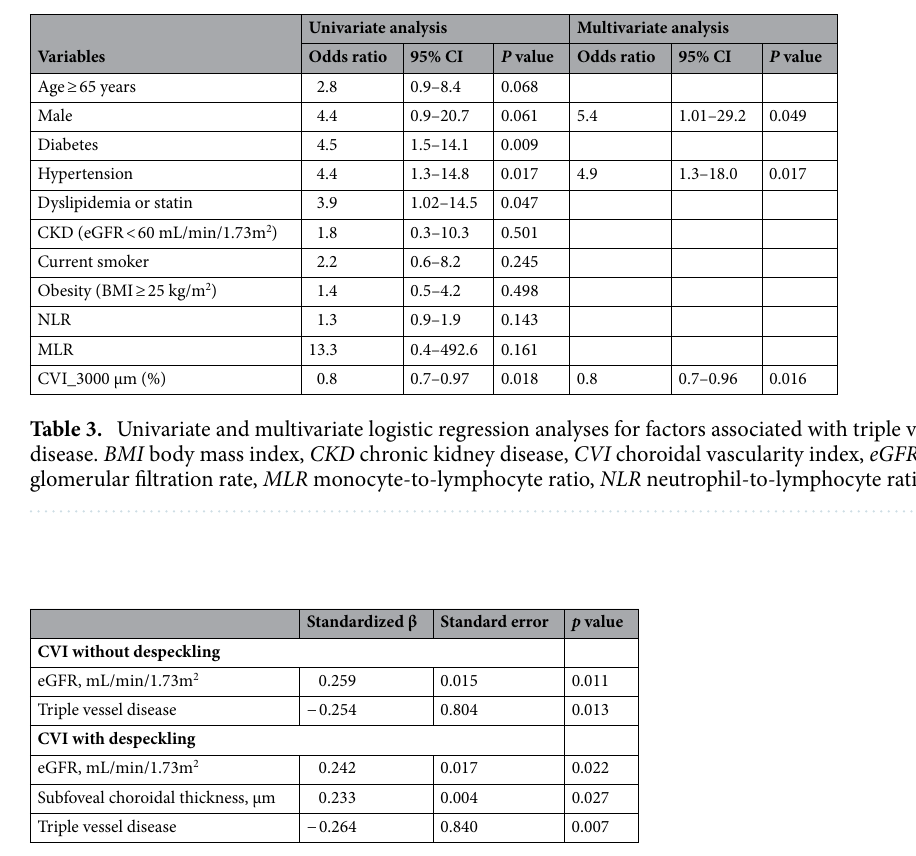
Table 4. Multiple linear regression analysis for factors associated with choroidal vascularity index measured on the 3000 μm range. CVI choroidal vascularity index, eGFR estimated glomerular filtration